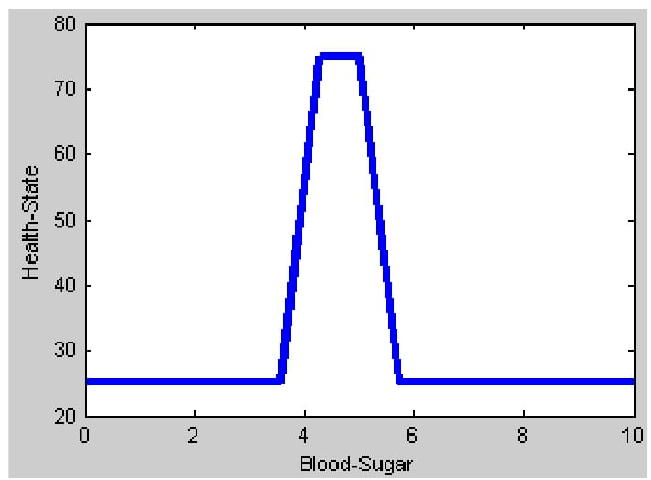
Figure 15. Output plot for Blood Sugar input.